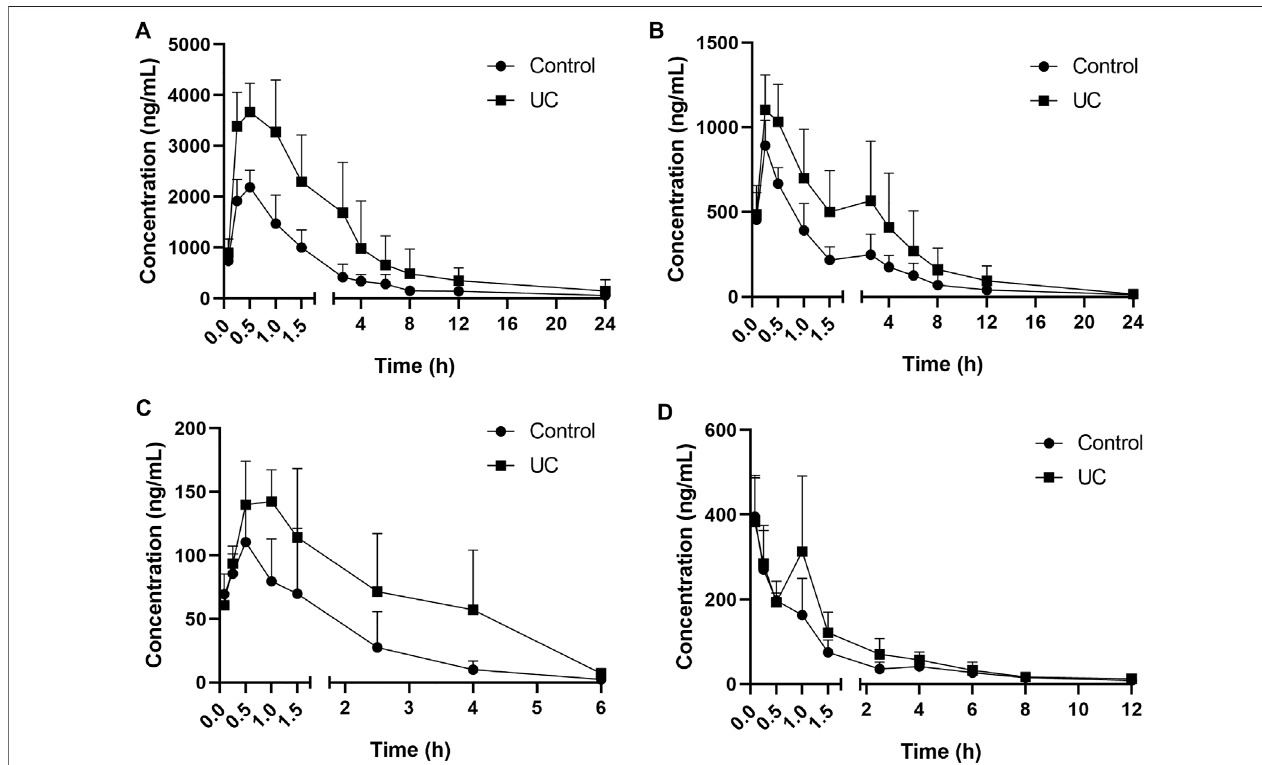
FIGURE 3 | Mean serum concentration – time curves for (A) andrographolide, (B) dehydroandrographolide, (C) , 1-methoxicabony- β -carboline, (D) 4-methoxy-5- hydroxy-canthin-6-one ( n = 8).